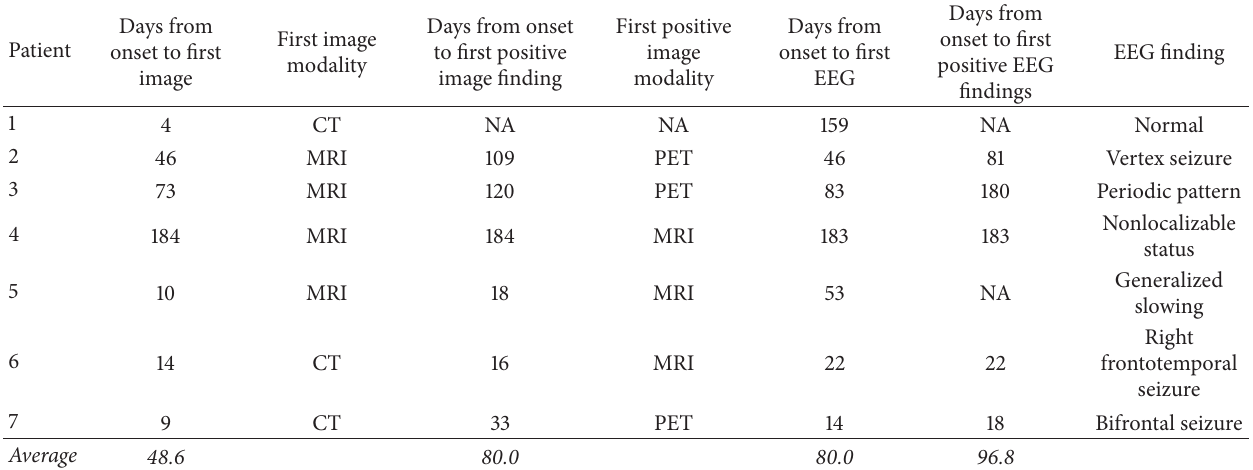
Table 2: Structural and physiological workup.